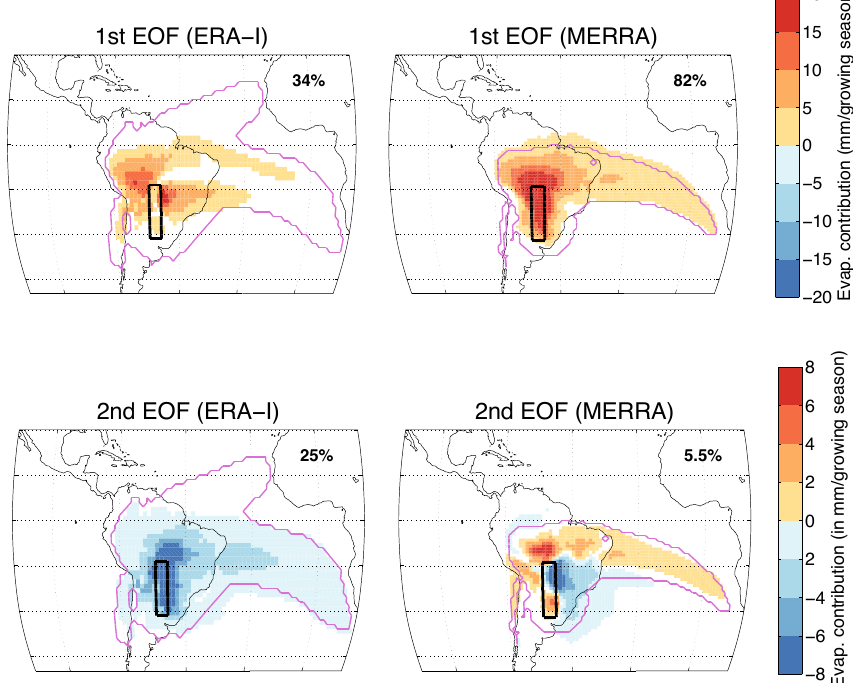
Fig. 8. Comparison of first and second EOFs for La Plata (ERA-Interim on left and MERRA on right ), for the period 1980-2011. The magenta line indicates the 5mm growing season 1 precipitationshed boundary, the black box indicates the sink region, and the bold number in the upper right corner indicates the amount of variance explained by the associated pattern. We do not show values < 2 mm growing season 1 , for the sake of clarity in the figure.